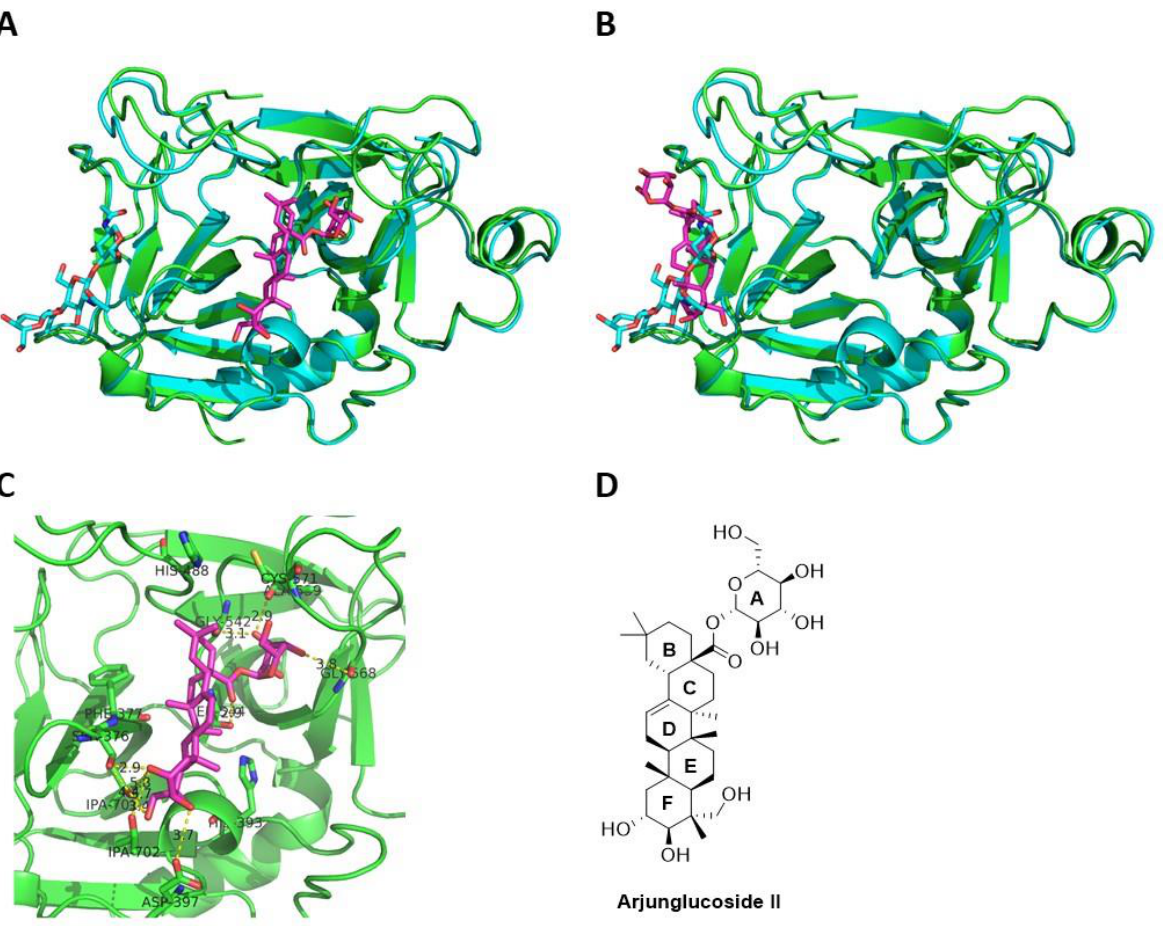
Figure 6. Molecular docking studies of arjunglucoside II in FXII. ( A ) Docked arjunglucoside II (magenta) in the active site of the deglycosylated catalytic domain of factor XII (green, PDB: 4XDE), superposed with the glycosylated catalytic domain of factor XII (cyan, PDB: 4XE4); ( B ) docked arjunglucoside II (magenta) in the glycosylated site of the deglycosylated catalytic domain of factor XII (green, PDB: 4XDE), superposed with the glycosylated catalytic domain of factor XII (cyan, PDB: 4XE4); ( C ) important interactions between docked arjunglucoside II (magenta) and nearby residues in the active site of the deglycosylated catalytic domain of factor XII (green, PDB: 4XDE); ( D ) structure of arjunglucoside II.